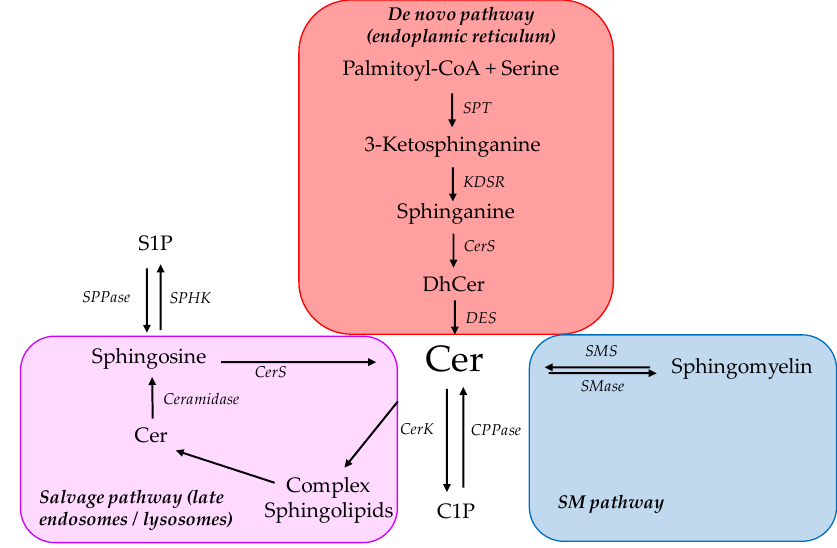
Figure 1. Ceramide biosynthesis pathways. Simplified overview of the main ceramide synthesis and degradation pathways. C1P Ceramide-1-phosphate; Cer Ceramide; CerK Ceramide kinase; CerS Ceramide synthase; CPPase Ceramide-1-phosphate phosphatase; DES Dihydroceramide desaturase; DhCer Dihydroceramide; KDSR Ketosphinganine reductase; S1P Sphingosine-1-phosphate; SM Sphingomyelin; SMase Sphingomyleinase; SMS Sphingomyelin synthase; SPHK Sphingosine kinase; SPPase Sphingosine-1-phosphate phosphatase; SPT Serine pamitoyltransferase.